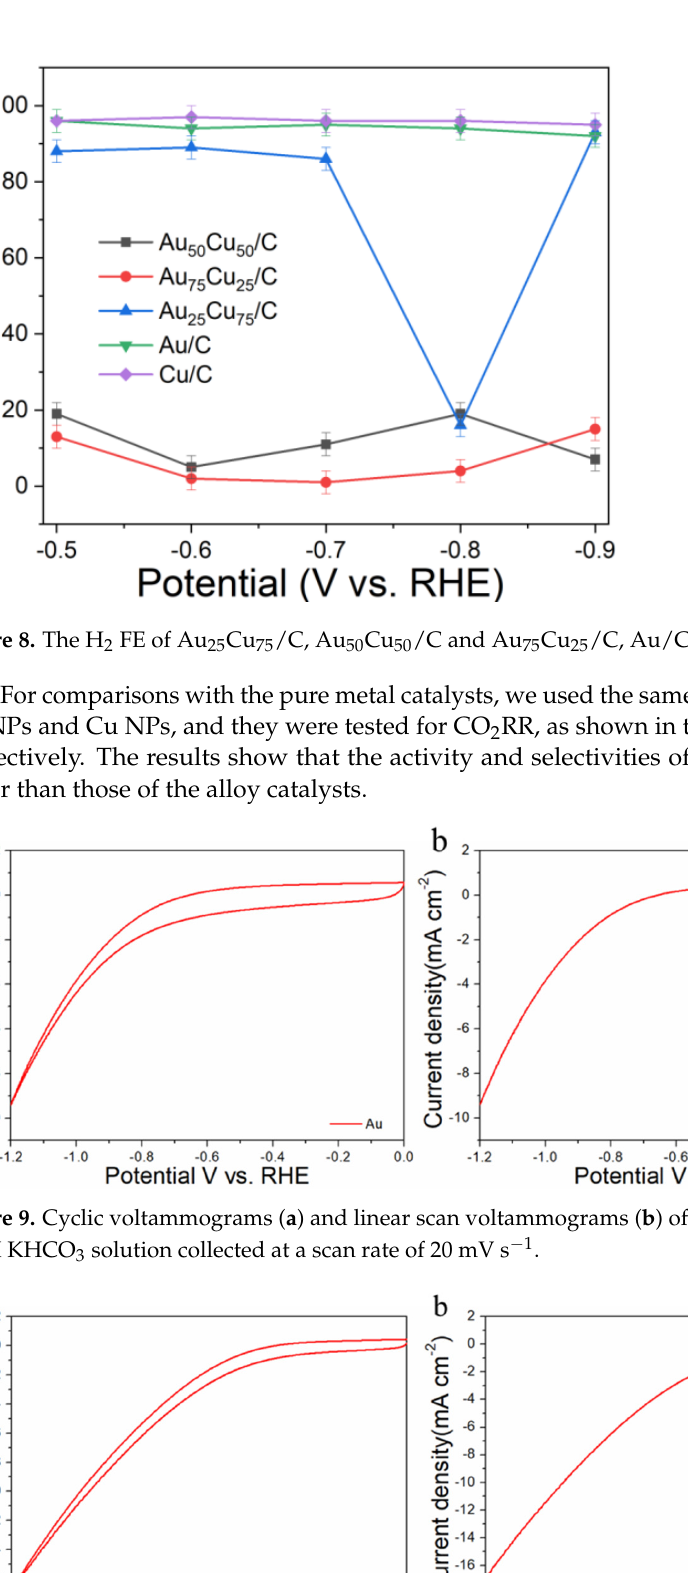
Figure 9. Cyclic voltammograms ( a ) and linear scan voltammograms ( b ) of Au/C in CO 2 -satruated 0.1 M KHCO 3 solution collected at a scan rate of 20 mV s − 1 . Figure 11. The XPS of Au 75 Cu 25 /C after the stability test. ( a ) Au and ( b ) for XPS data. 4. Conclusions In summary, an Au n Cu 100 − n alloy dominant (111) facet was synthesized with a sim- ple method. The composition of Au n Cu 100 − n alloy can be simply controlled by adjusting the Au/Cu atomic ratio of the precursor. Na 2 S 2 O 3 and NaOH as inhibitors that also pre- vent NPs aggregation play important roles in the synthesis of Au n Cu 100 − n . Au 75 Cu 25 /C ex- hibits excellent catalytic activity and stability for CO 2 electroreduction. The excellent cat- alytic performance of Au 75 Cu 25 /C mainly depends on the large specific surface area and inter-lattice shrinkage. Meanwhile, the coordination of Au and Cu in the catalyst is also a reason for its good stability and the good performance of the catalyst. Au 75 Cu 25 /C had the highest Faradaic efficiency and the highest CO selectivity compared with pure gold catalysts in the CO 2 reduction process. Our study on Au n Cu 100 − n alloy catalysts demon- strated that the formation of alloys of noble metals with inexpensive metals can improve the activity and selectivity of the catalysts, which provides a new strategy for the design of catalysts for CO 2 RR. Author Contributions: Conceptualization, F.C., C.W. and L.Y.; formal analysis, F.C., C.W. and X.W.; data curation, C.W., X.W., Y.L. and J.W.; writing—original draft preparation, F.C. and C.W. and Y.L.; writing—review and editing, Y.L., J.W. and Z.B.; supervision, L.Y.; project administra- tion, L.Y.; funding acquisition, F.C., Z.B. and L.Y. All authors have read and agreed to the pub- lished version of the manuscript. Funding: This research was funded by the National Science Foundation of China (grant number 21908045, 52072114, 51922008 and 51872075), the 111 Project (grant number D17007) and Henan Center for Outstanding Overseas Scientists (grant number GZS2022017). Institutional Review Board Statement: Not applicable. Informed Consent Statement: Not applicable.